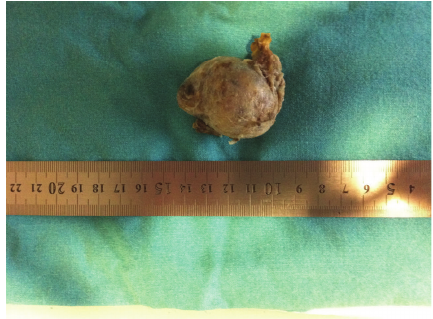
Figure 3: Resected 5 × 6 × 5cm in diameters mass.